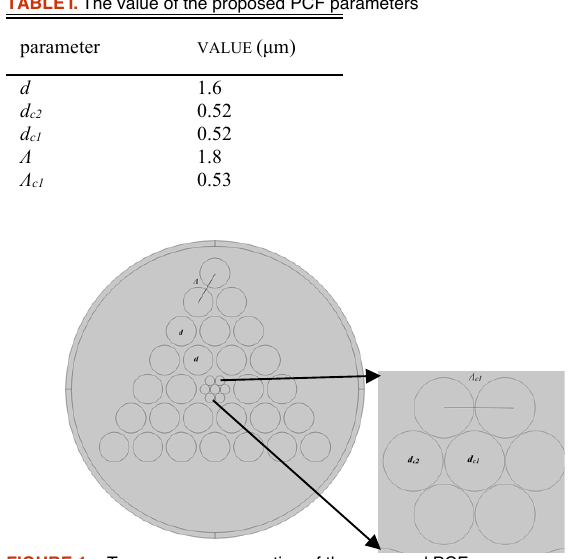
FIGURE 1. Transverse cross section of the proposed